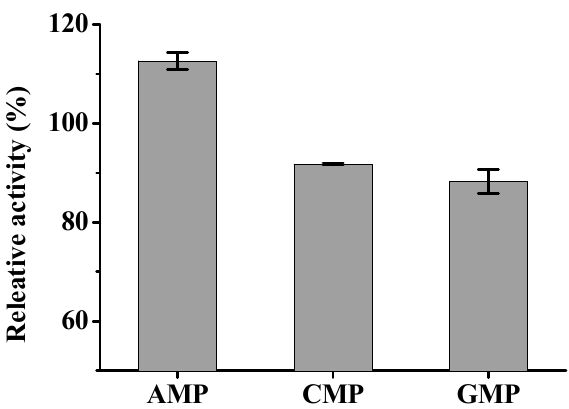
Figure 4. Relative activity of immobilized CRL by Zn 2+ with different nucleotide (AMP, CMP and GMP).